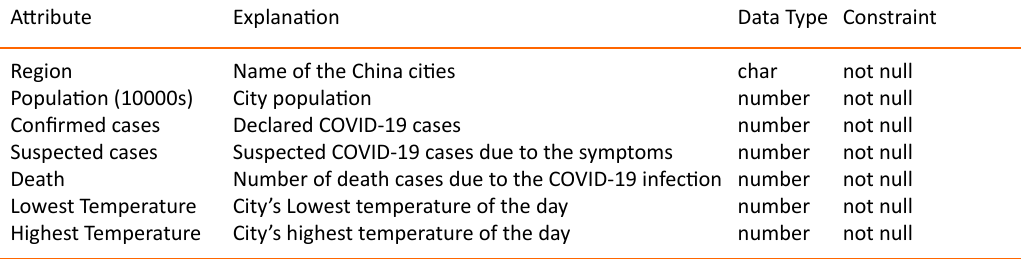
Table 1. Description of attributes used in COVID-19 Data Set Attribute